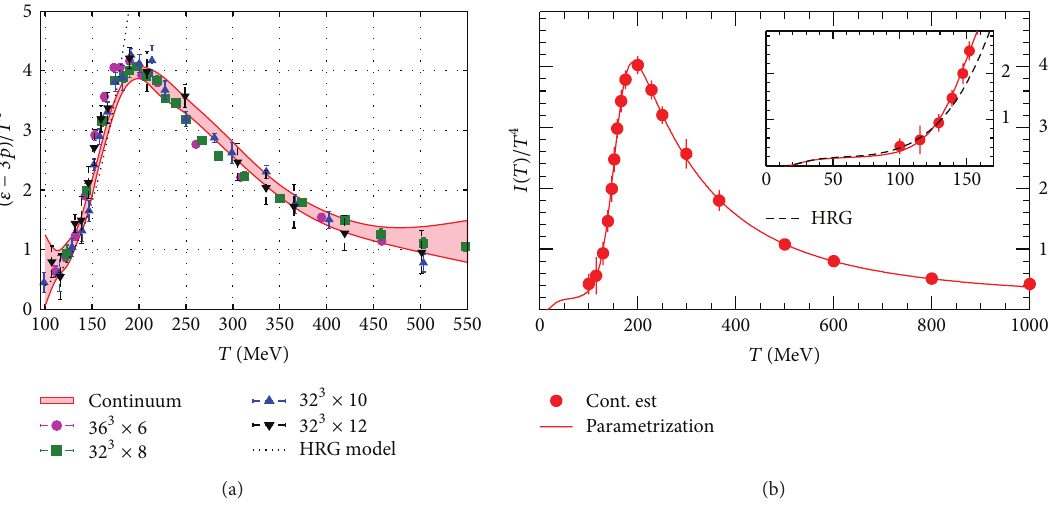
Figure 3: The latest data with the stout smeared fermions (a), from [50]. In (b), the fit to the trace anomaly data from the continuum extrapolation of the 𝑁 𝜏 = 6, 8 results, from [19]. The results are in perfect agreement with the Hadron resonance gas model calculations for 𝑇 < 140